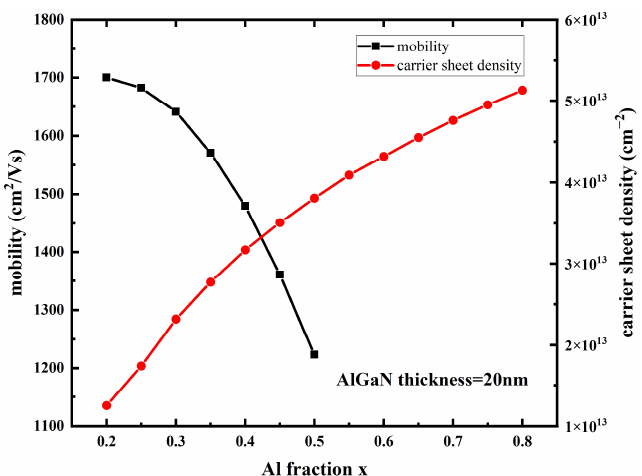
Figure 6. Mobility and carrier sheet density of devices with different Al components in barrier lay- ers.